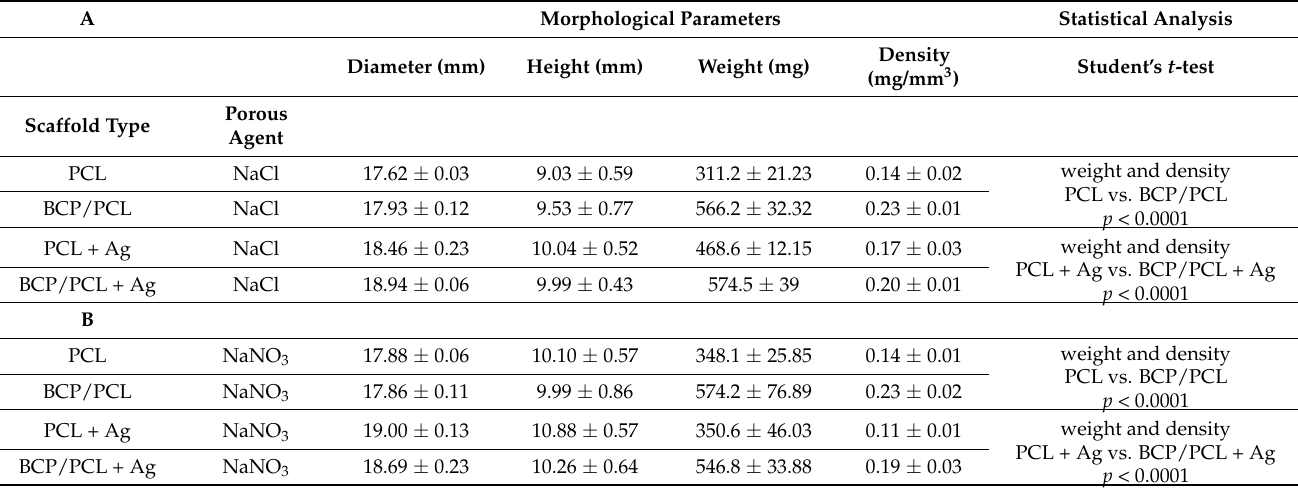
Table 1. Morphological characteristics (reported as mean ± standard deviation) of the different PCL-based scaffolds obtained with both NaCl ( A ) and NaNO 3 ( B